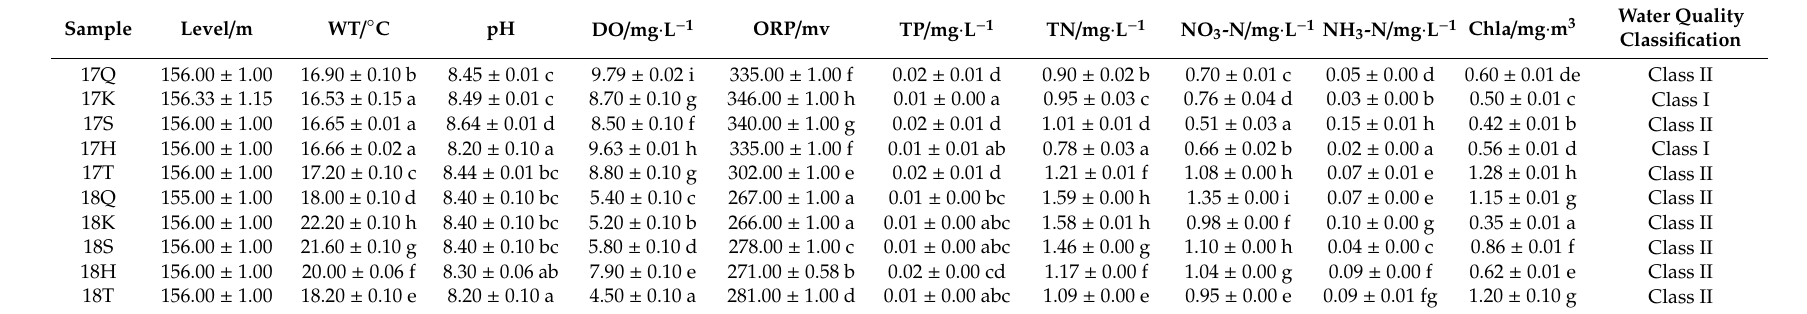
Table 2. Physical and chemical properties in the Danjiangkou